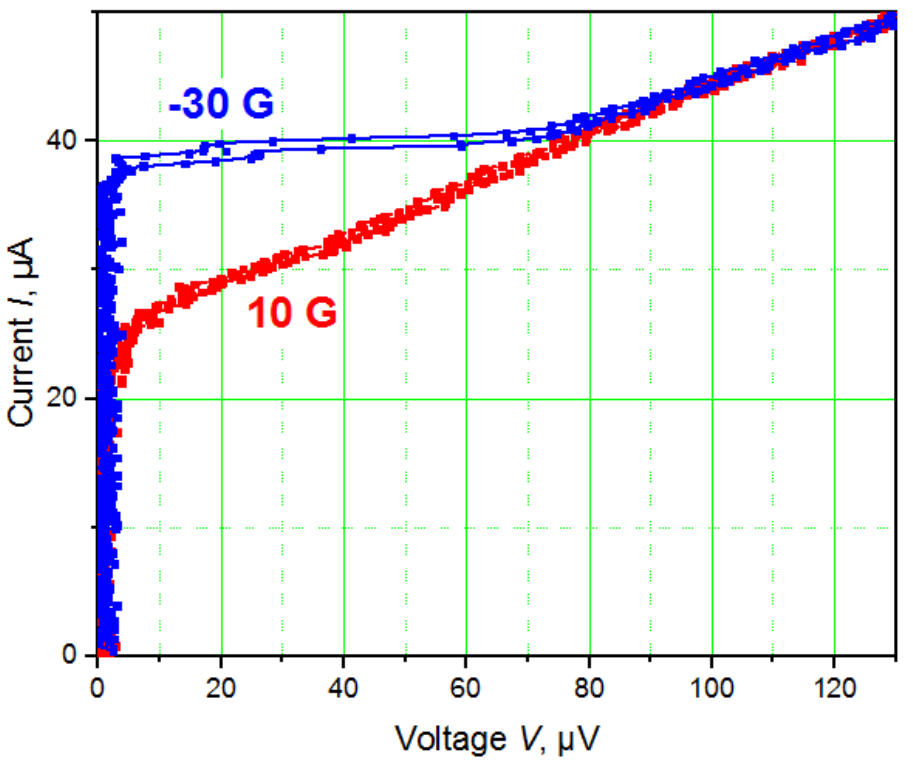
Figure 6. I ( V ) dependences measured for a planar nanoSQUID with NbN-TiN-NbN junctions in Figure 6. I(V) dependences measured for a planar nanoSQUID with NbN-TiN-NbN junctions in magnetic fields of − 30 G (blue) and 10 G (red) at 4.2 magnetic fields of -30 G (blue) and 10 G (red) at 4.2 K.